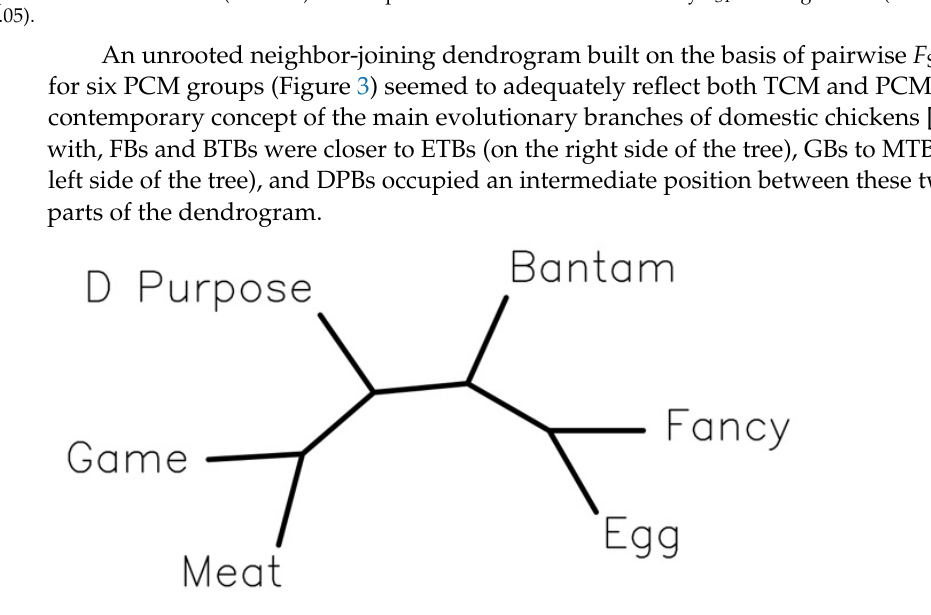
Figure 3. An unrooted phylogenetic tree constructed using the neighbor-joining method and based on the F ST values (Table 2) inferred from allele frequencies in the five SNPs for six chicken breed/population groups as clustered according to PCM (Figure